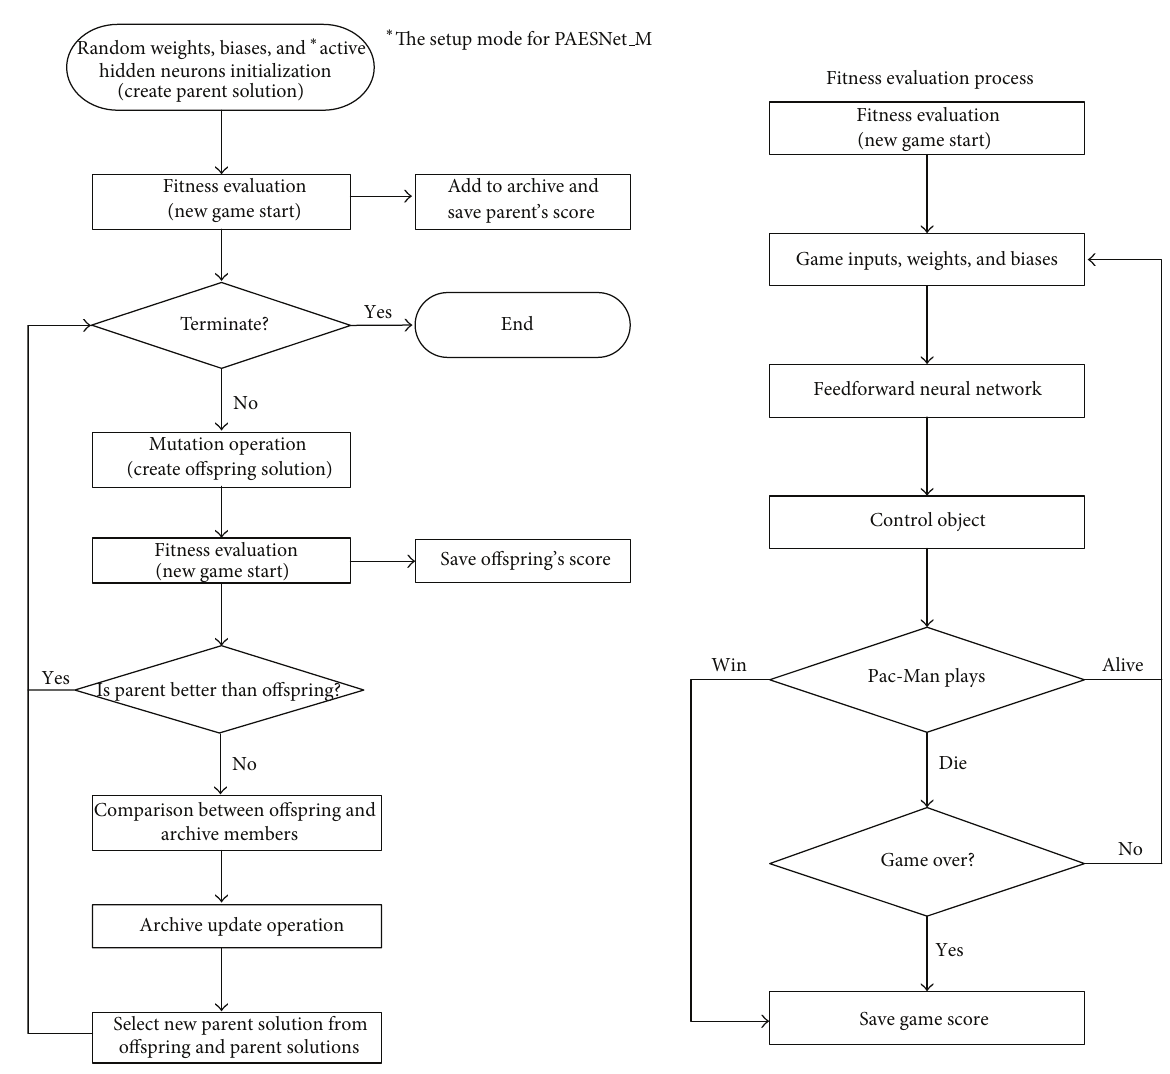
Figure 2: The flowchart of PAESNet